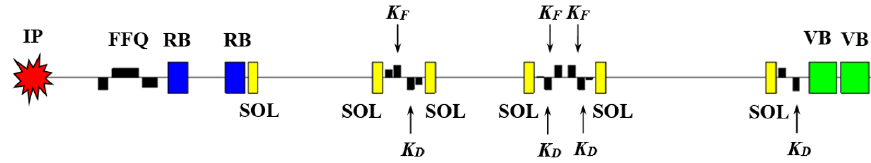
Figure 5. Distributed snake (one half) based on short 6 T SC solenoids